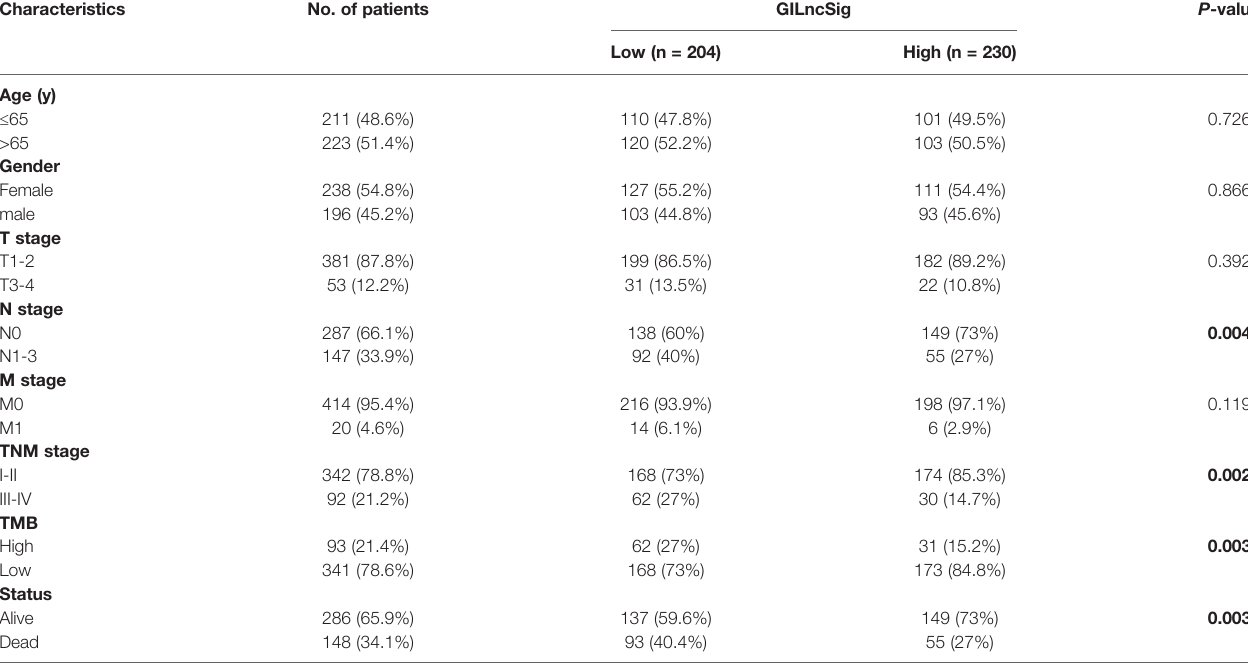
TABLE 3 | Correlations between GILncSig and clinical characteristics of LUAD patients in TCGA.